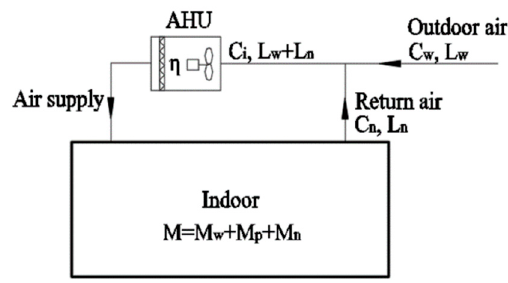
Figure 5. Schematic diagram of a centralized system without outdoor air pretreatment.